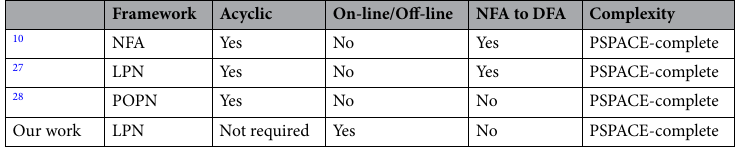
Table 3. Observer net for current-state opacity